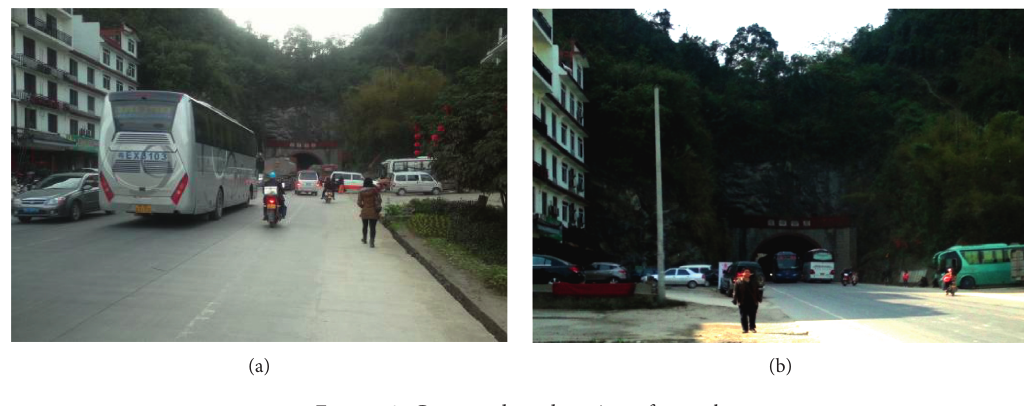
Figure 3: Congested road section of tunnel.